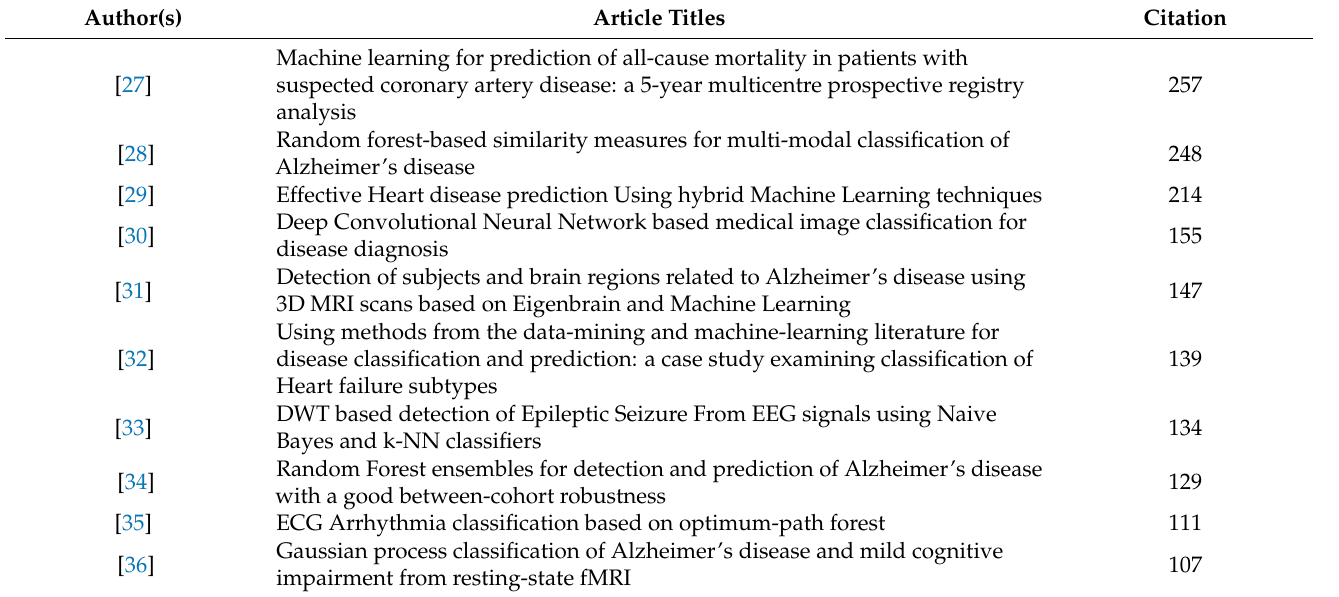
Table 1. Top ten cited papers published in MLBDD in between 2012–2021 based on Scopus and WOS